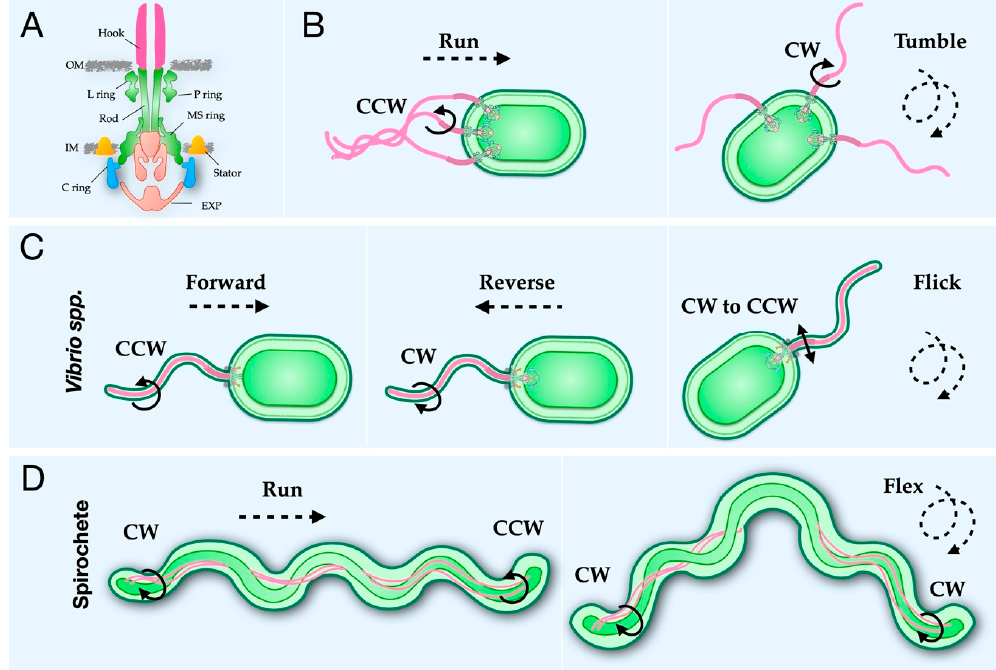
Figure 1. Bacterial flagella control distinct motility. The flagellar motor is a complex nanomachine that drives filament rotation. ( A ) Cartoon model of the flagellar motor. ( B ) In the two-step model used by many species, such as E. coli and Salmonella , the cell body is propelled forward, or runs, during counterclockwise (looking from the motor to the filament, CCW) rotation, and the filaments form an organized bundle. To change direction, the cell tumbles by rotating the filament in the clockwise (CW) direction, unwinding the bundle. ( C ) Vibrio spp. use a three-step method, with CCW rotation moving the cell body forward, CW rotation moving the cell body in reverse, and a flicking motion when CW- to-CCW randomly change direction. ( D ) Spirochetes, with periplasmic flagella at both poles, require a unique two-step method. During the run, the flagella rotate CCW and CW at opposite poles, such that one pole “pulls” while the other “pushes”. Both poles rotate in the CW direction while the cell tumbles to change